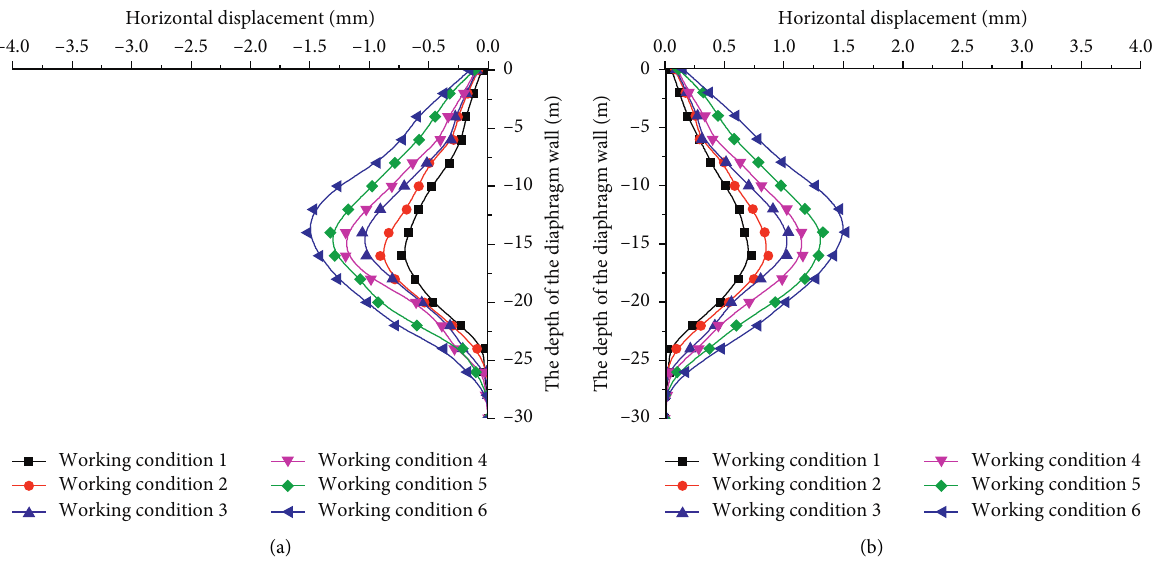
Figure 19: Horizontal displacement of the diaphragm wall under different working conditions. (a) Measuring point 20. (b) Measuring point 4.